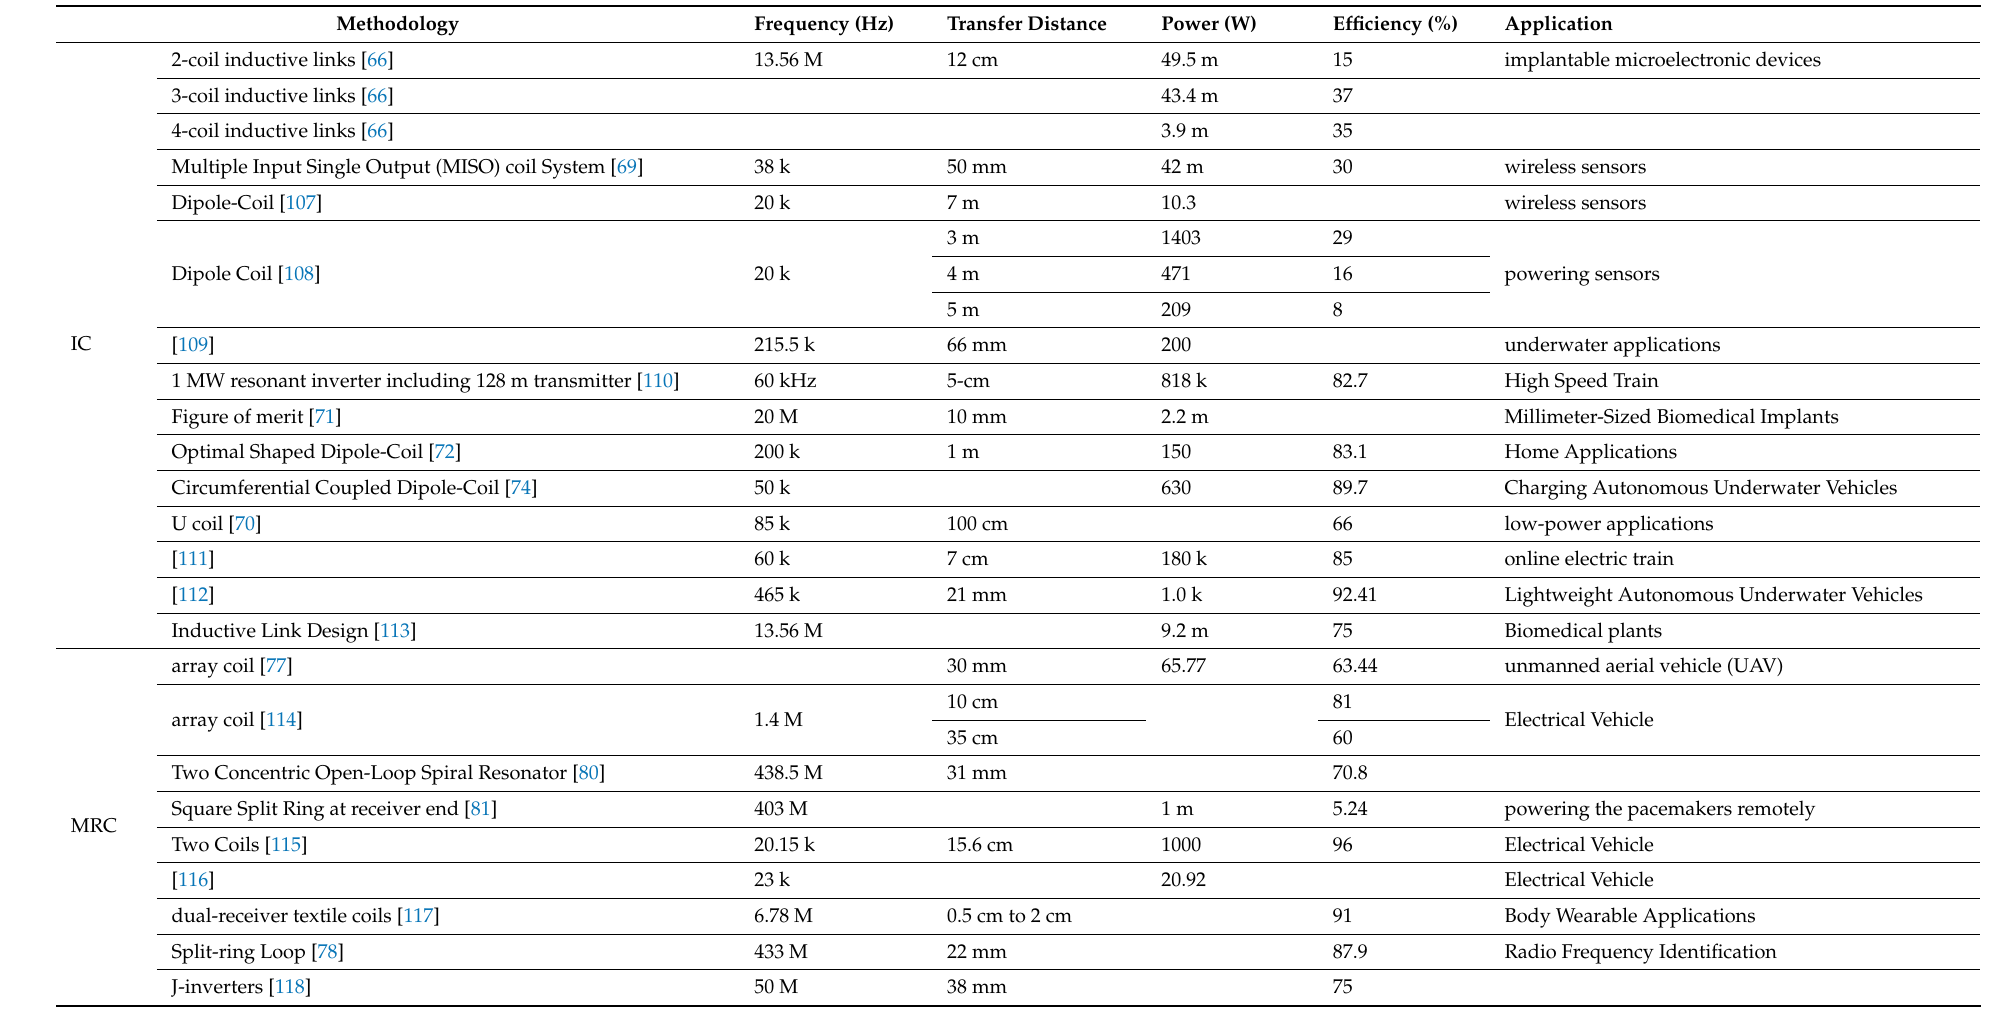
Table 1. Comparison between different near-field WPT